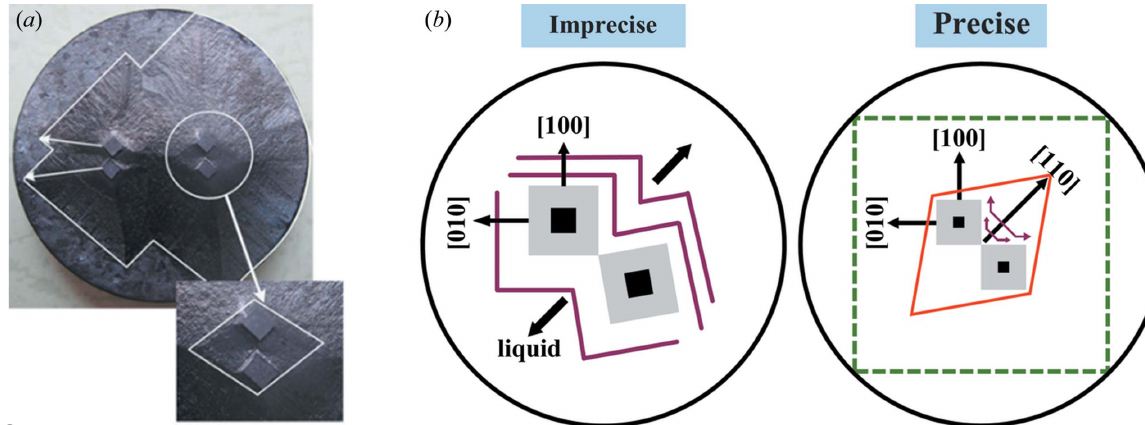
Figure 2 ( a ) Photographs of the top view of a GdBCO crystal induced by two sets of (110)/(110) arranged double-seeds. From the left set, two crystals with concave joints independently propagated at a normal rate, while the right-set-induced crystals combined into a large single crystal with a rapid-growth zone, as amplified in the inset (white diamond frame). ( b ) Schematic illustrations of growth modes corresponding to imprecisely and precisely (110)/(110) arranged